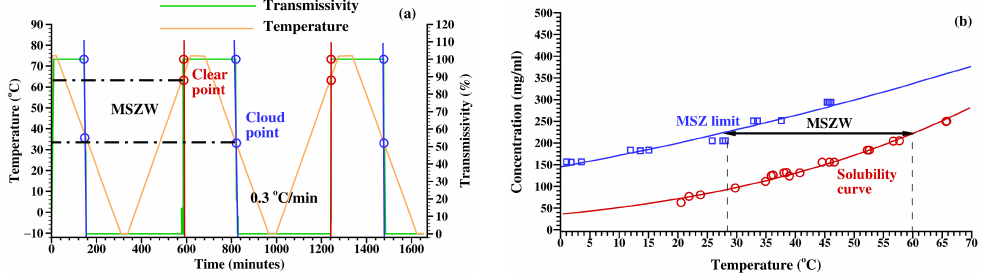
Figure 2. ( a ) Detection of clear and cloud points, ( b ) Solubility curve and MSZ